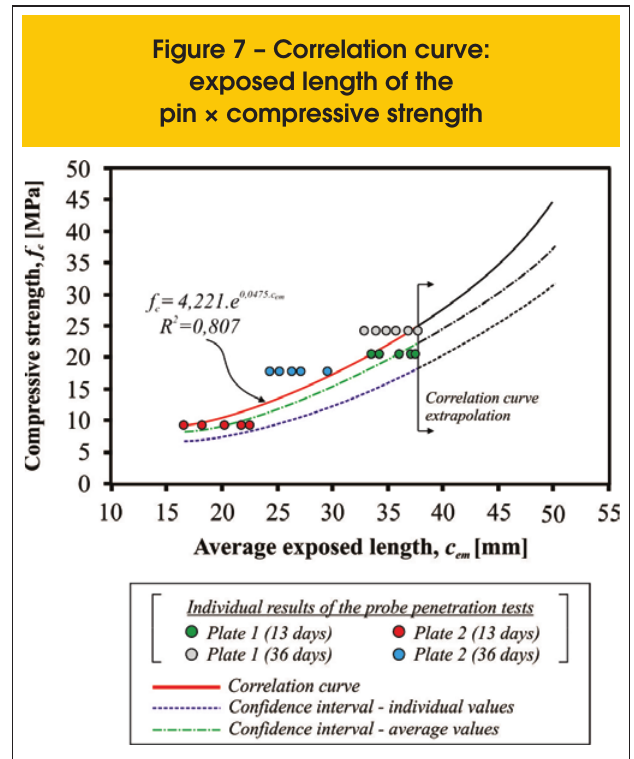
Figure 7 – Correlation curve: exposed length of